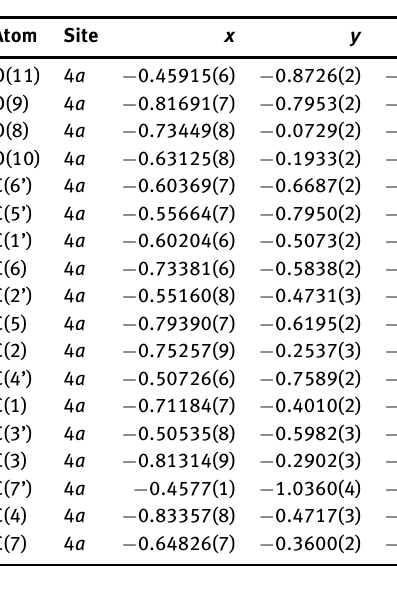
Table 3: Atomic displacement parameters (Å 2